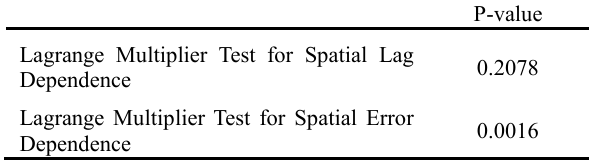
Table 4 . Moran’s I for regression residuals